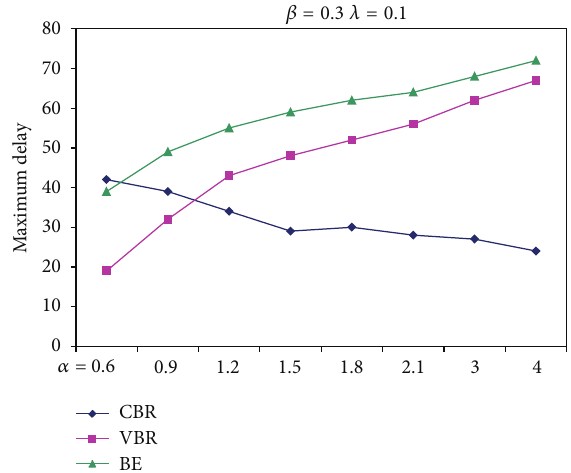
Figure 8: Maximum delay suffered for different values of 𝛼 when 𝛽 and 𝜆 are kept